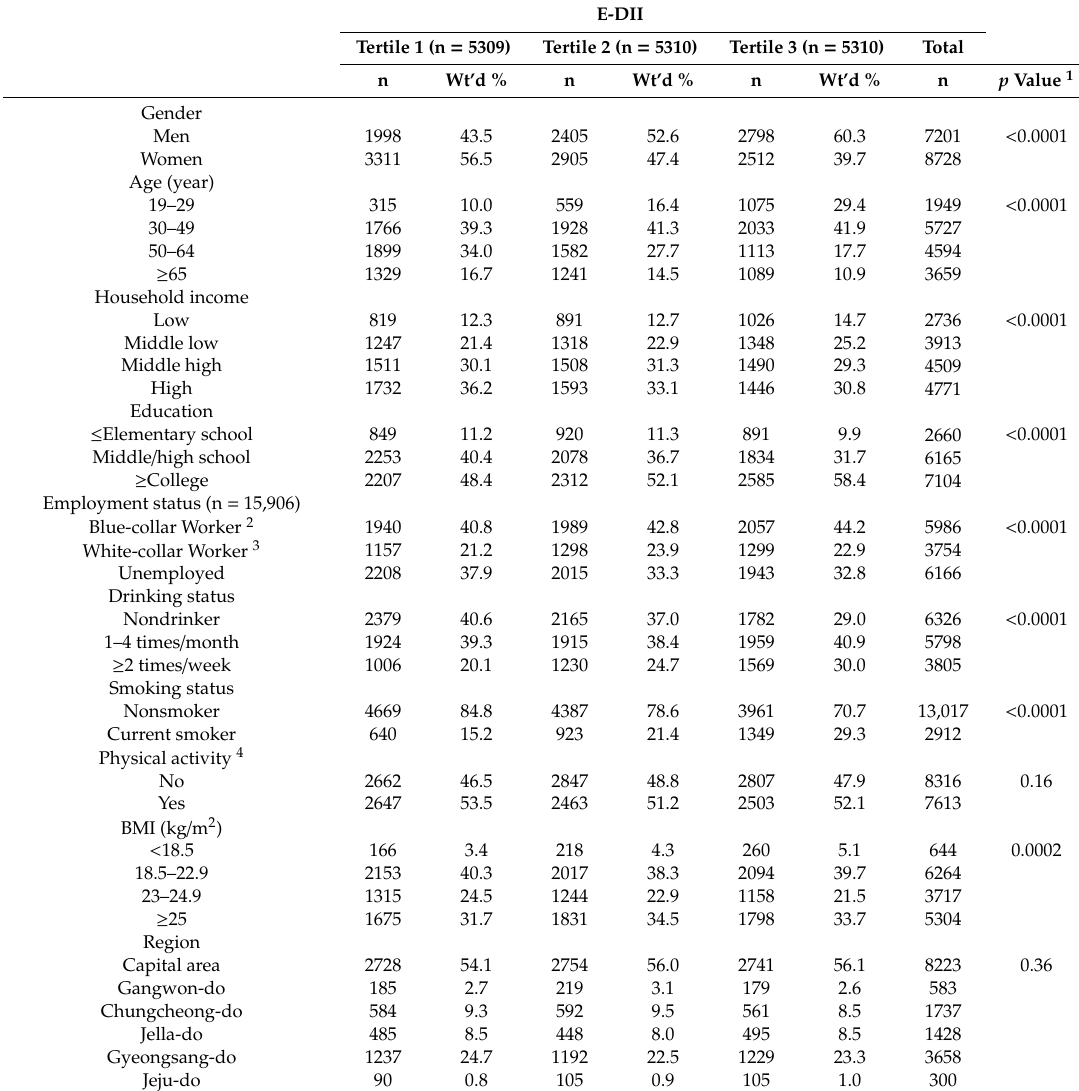
Table 1. Distributions of sociodemographic and lifestyle factors by tertiles of energy-adjusted dietary inflammatory index